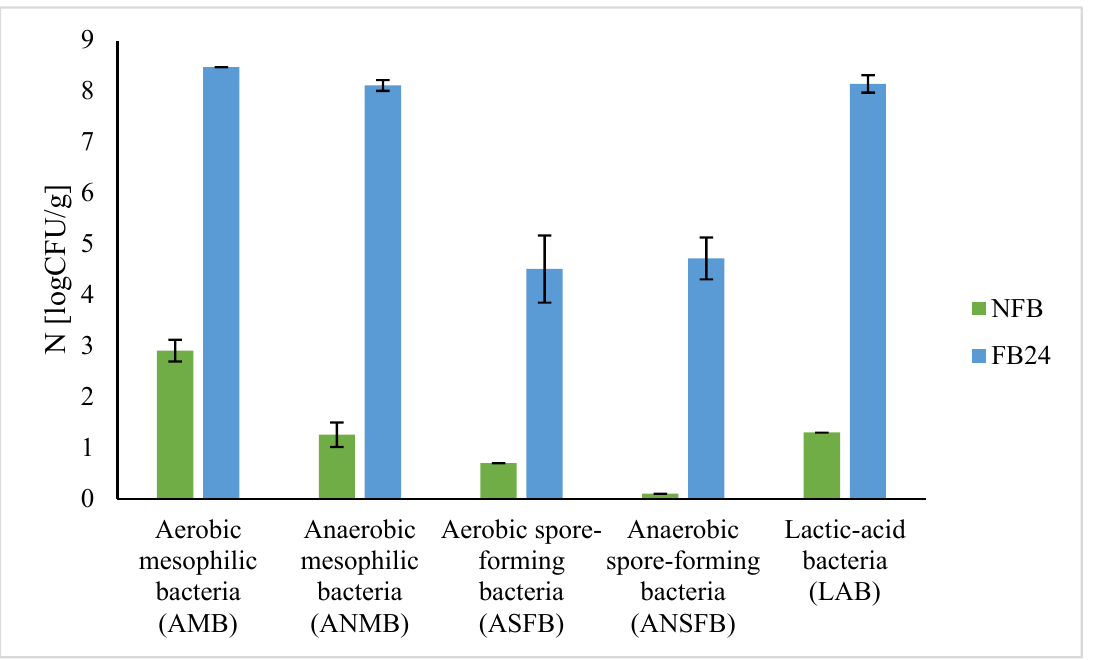
Figure 2. The average number (N [logCFU/g]) of different groups of microorganisms in NFB and FB ± SD. Table 1. Pathogenic bacteria, yeast, and moulds in non-fermented (NFB) and fermented A. platensis broth